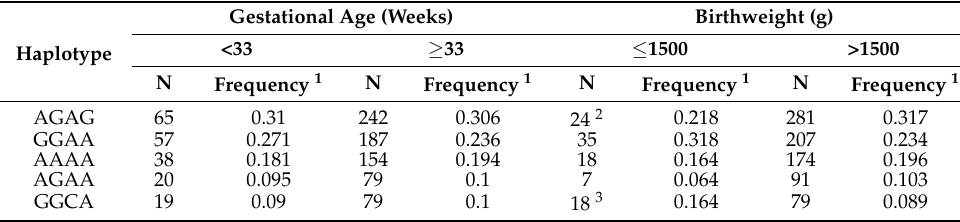
Table 4. Frequencies of the most common haplotypes in preterm newborns, depending on gestational age and